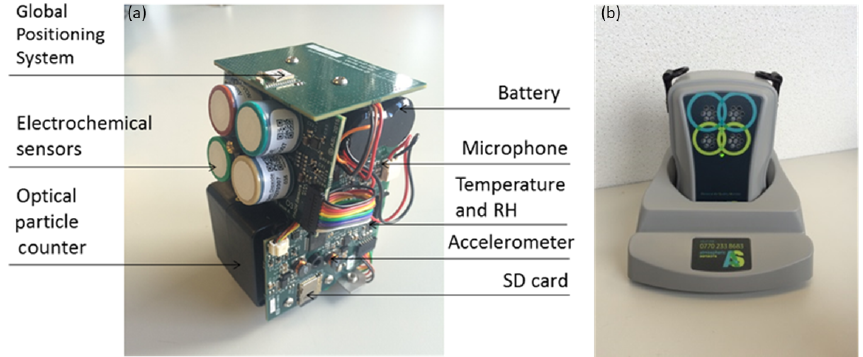
Figure 1. The personal air quality monitor. (a) Design of the PAM platform internals and (b) PAM charging inside the base station. The external dimensions of the PAM are 13cm × 9cm × 10cm. Table 1. Summary of monitored parameters of the PAM. PM 1 , PM 2 . 5 and PM 10 are the fraction of particles with an aerodynamic diameter smaller than 1, 2.5 and 10µm respectively. CO: carbon monoxide; NO: nitric oxide; NO 2 : nitrogen dioxide; O 3 : ozone. Parameter Method Sampling interval Spatial coordinates Global Positioning System (GPS) Background